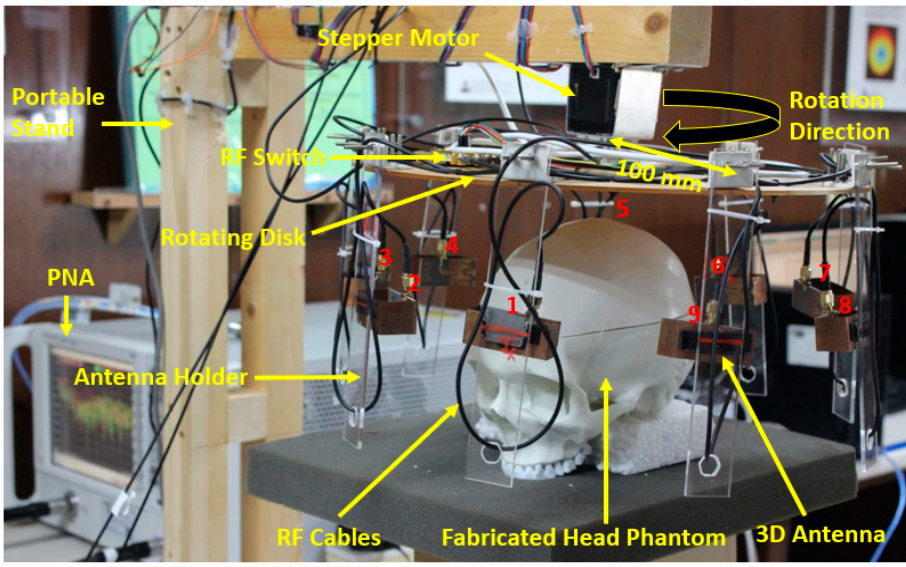
Figure 5. Experimental setup for sensors-based microwave brain imaging system [46] .